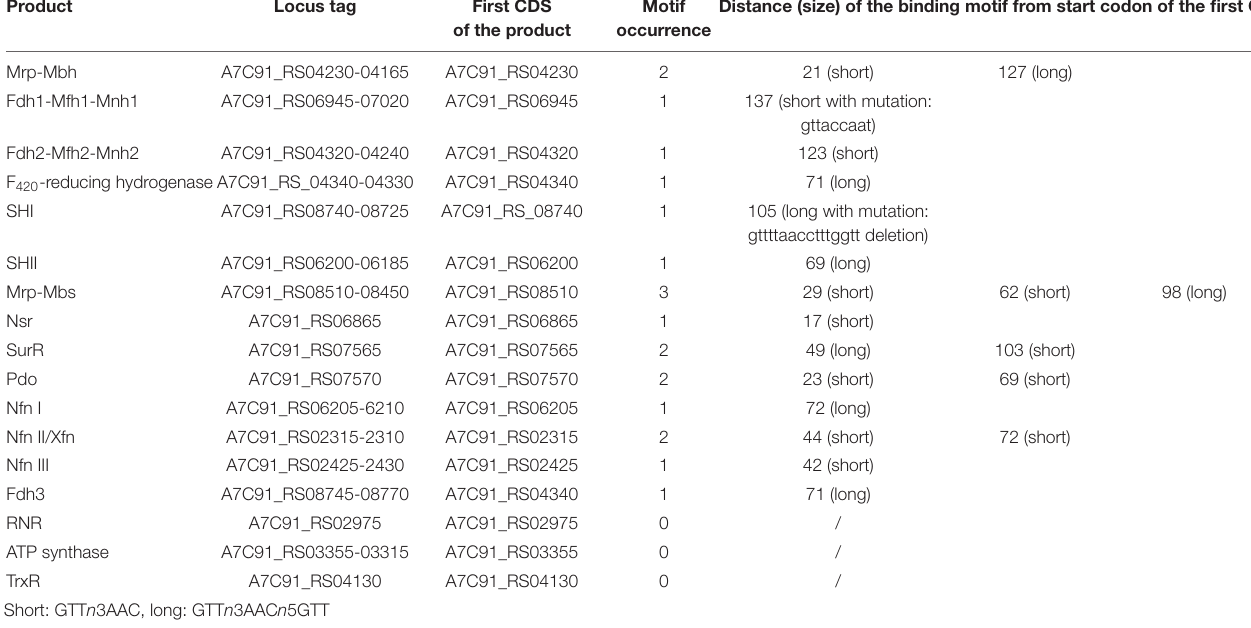
TABLE 2 | SurR binding motifs positions upstream from the start codon of CDS involved in the electron flow. Product Locus tag First CDS